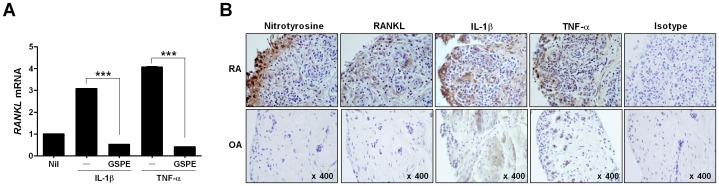
Effect of GSPE on RANKL mRNA expression in RA synovial fibroblasts.(A) RA synovial fibroblasts were cultured for 72 h with 1 ng/mL TNF-α or 0.1 ng/mL IL-1β in the presence of 10 µg/mL GSPE. Analysis of RANKL mRNA expression was performed using Real-Time PCR. Values represent the mean ± SD for three independent experiments. ***P<0.001 versus the IL-1β- or TNF-α-stimulated condition. (B) Immunohistochemical detection of nitrotyrosine, RANKL, IL-1β, and TNF-α in the synovium of patients with RA or OA. Background immunohistochemical staining of synovium tissue was performed with anti-isotype antibodies. All tissues were counterstained with hematoxylin (original magnification, ×400).